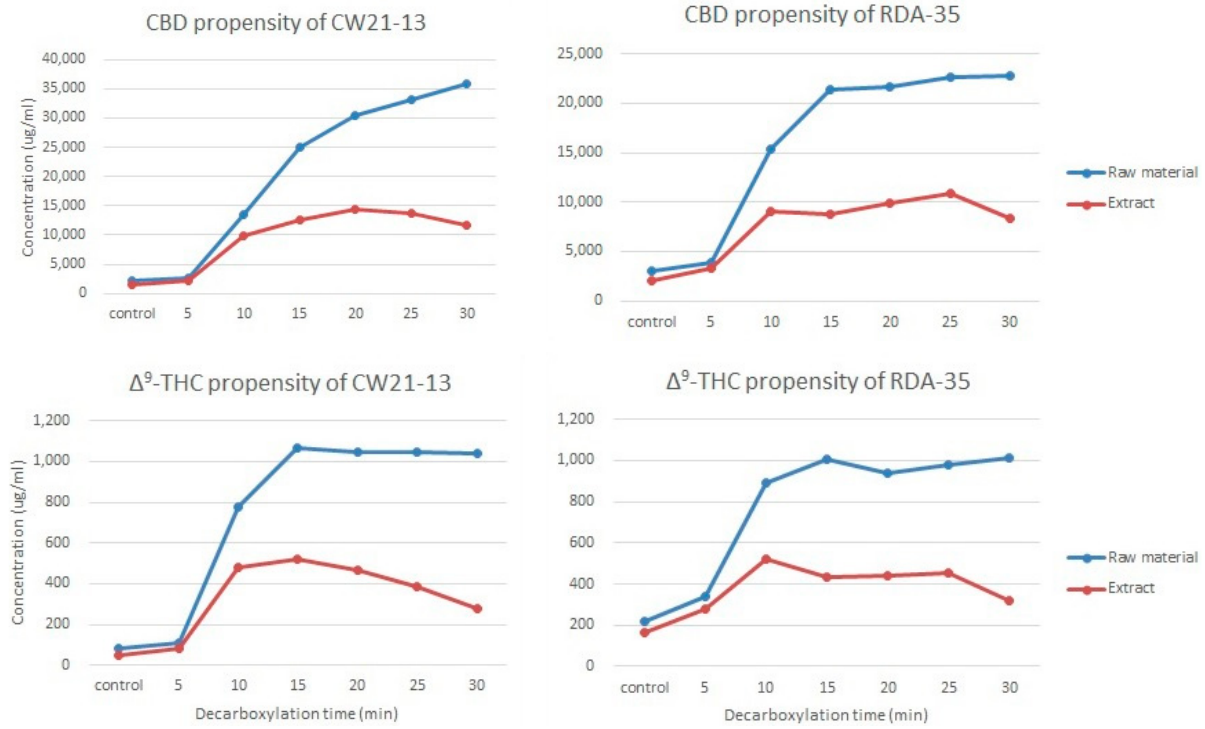
Figure 8. Loss of THC and CBD in different varieties at 135 °C for 30 min. Blue line, yield of raw material; red line, yield of extract. Samples were obtained every 5 min and analyzed, and all experiments were carried out simultaneously under the same conditions.